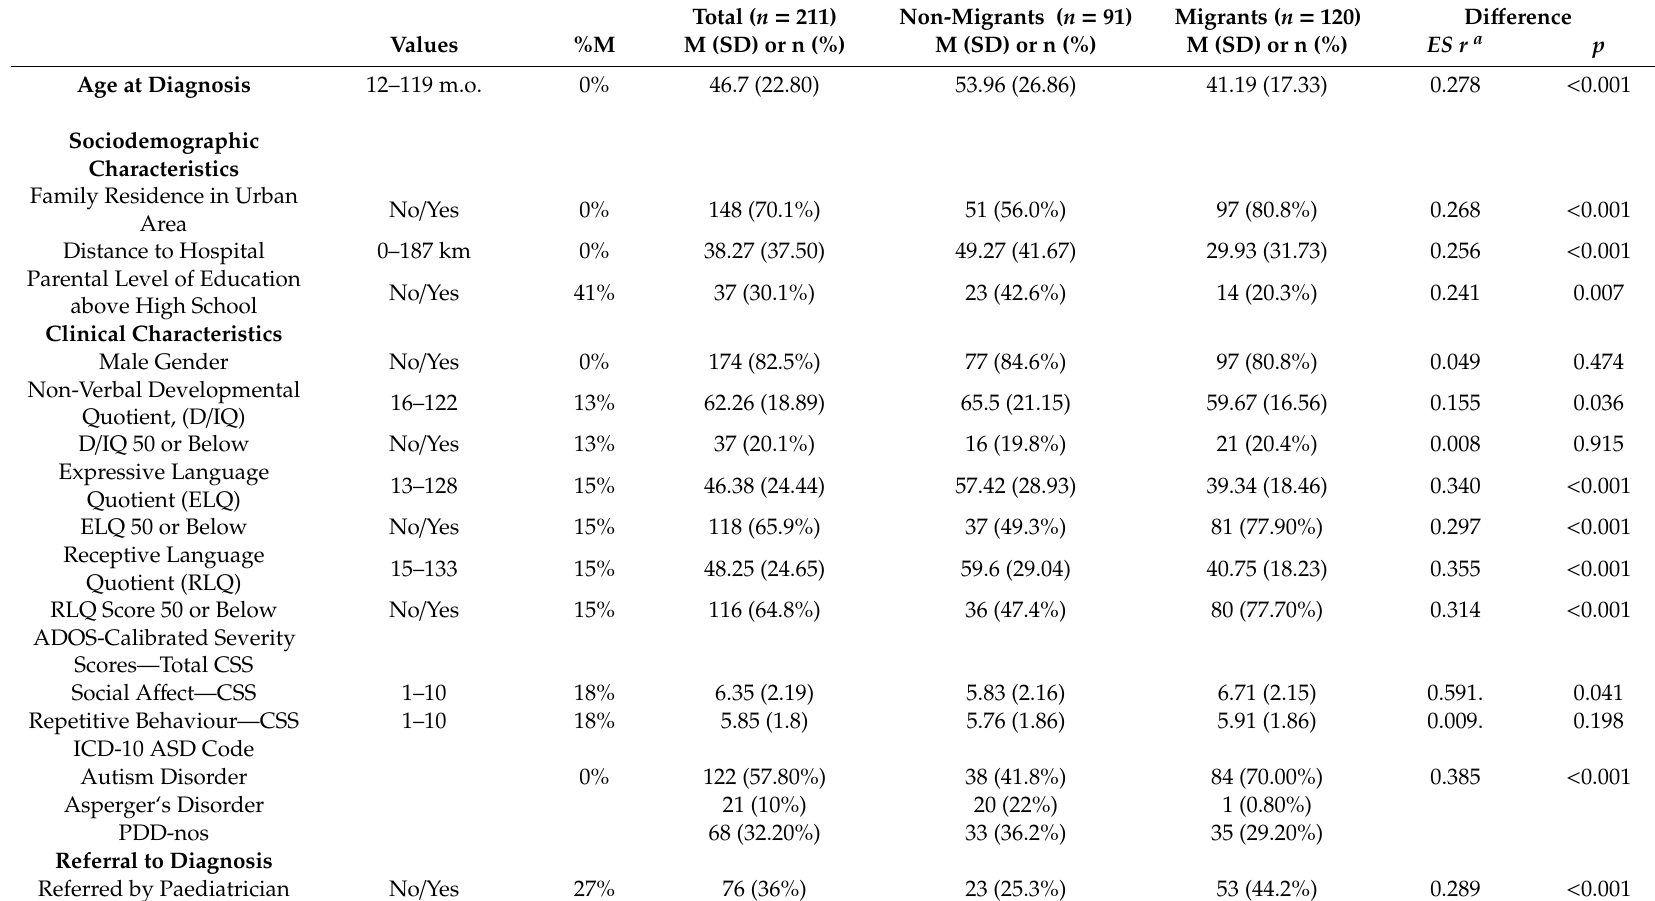
Table 1. Sample characteristics by migration